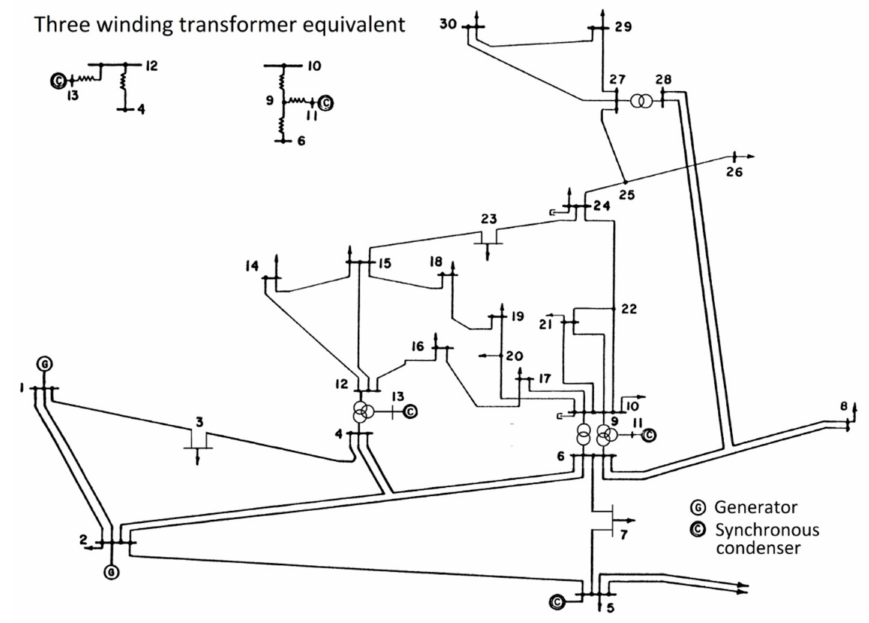
Figure 1. The IEEE 30-bus power